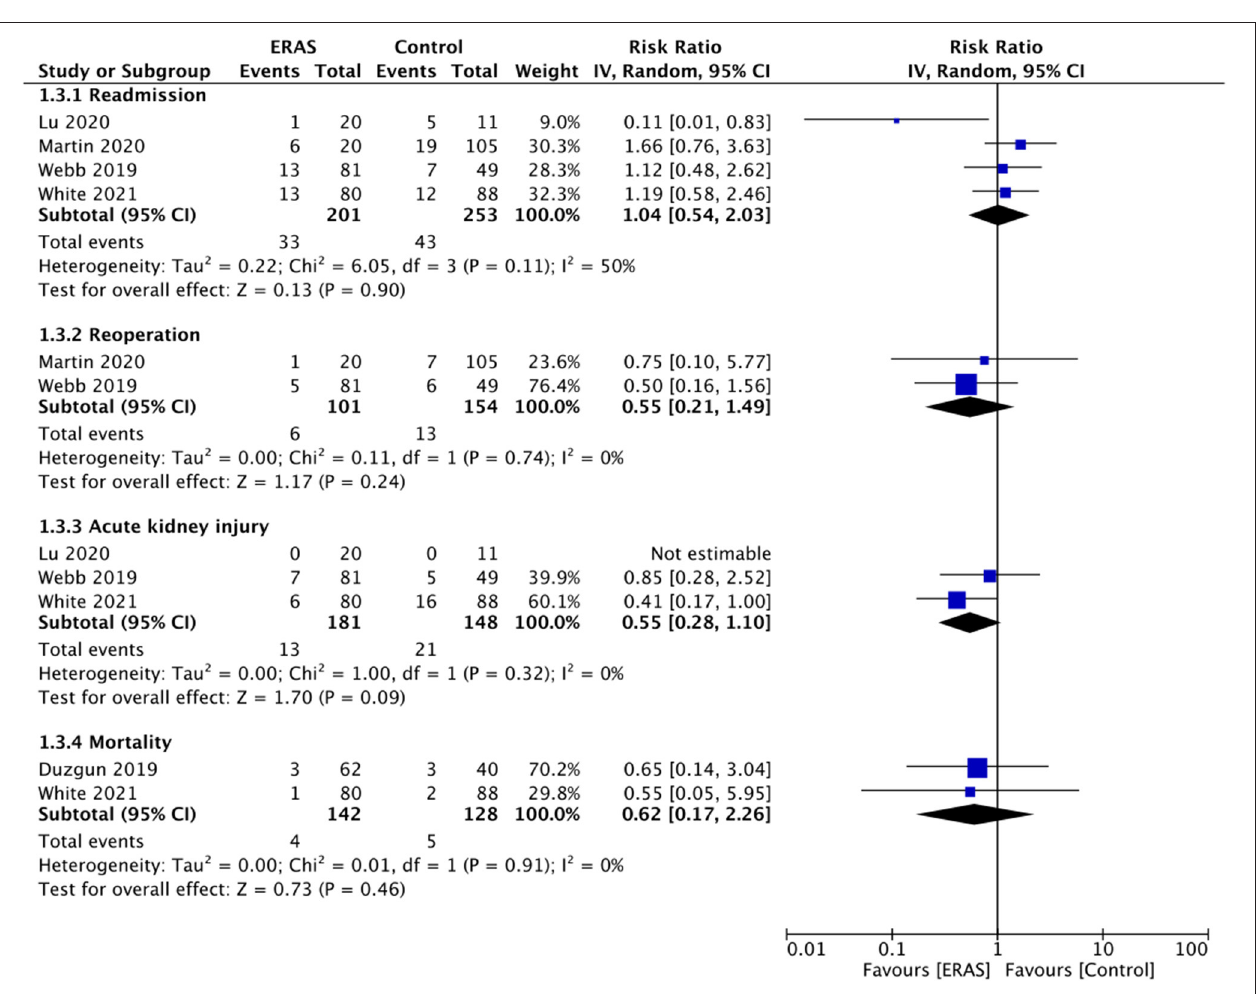
FIGURE 4 | Meta-analysis for readmission, reoperation, AKI and mortality between ERAS and control